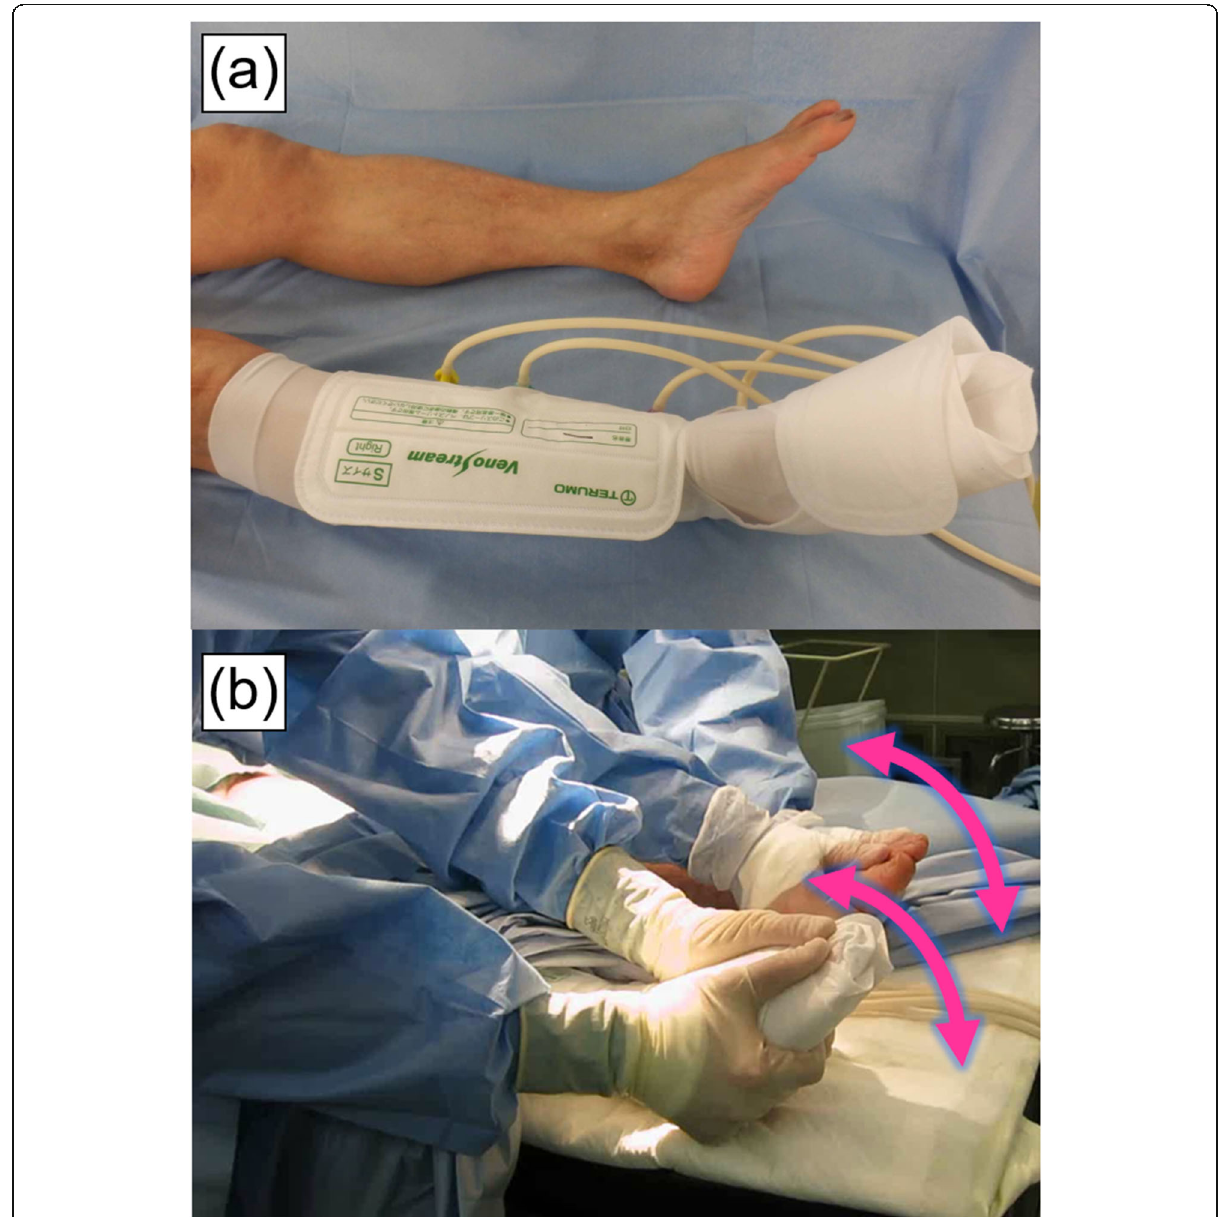
Fig. 2 Photographs of a gradual compression stocking (GCS) and intermittent pneumatic compression device (IPCD) ( a ) and intraoperative passive plantar flexion motion ( b